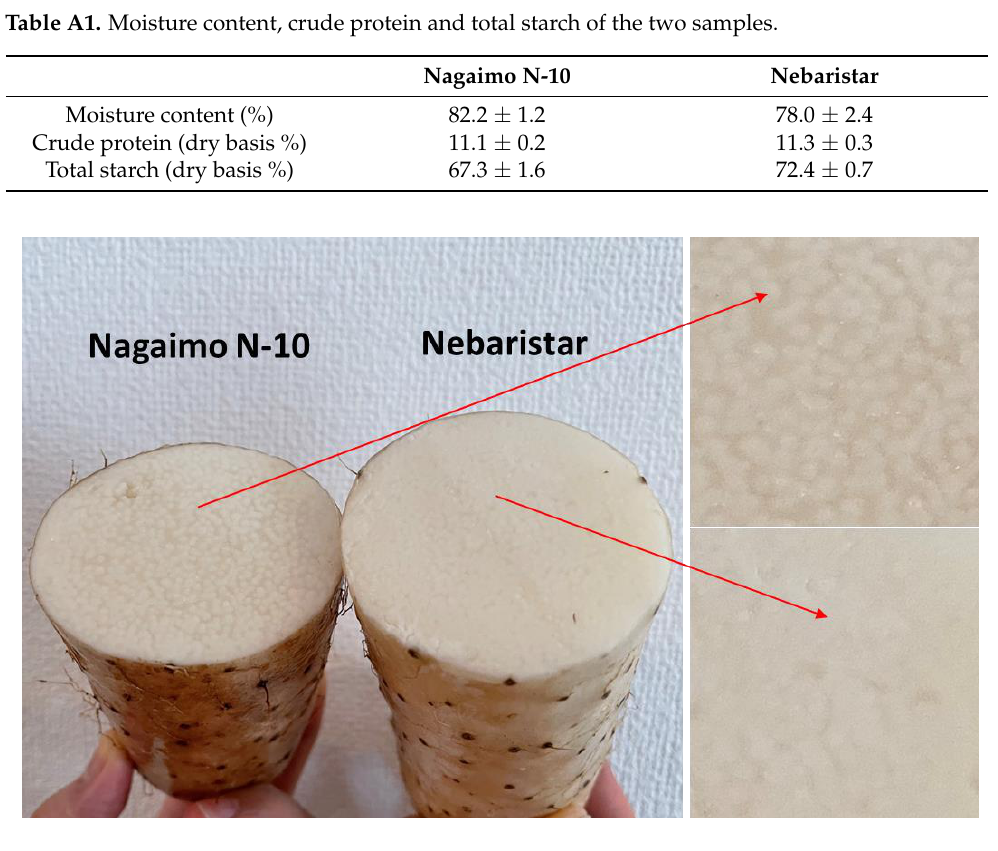
Figure A1. The appearance of the yam tuber samples.